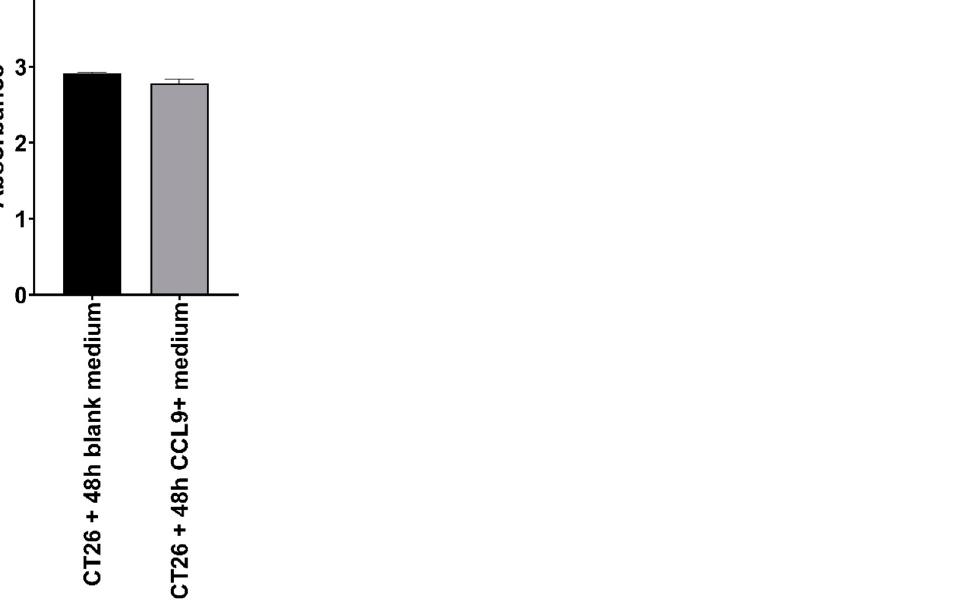
Figure 4. Migration of the unmodified CT26 cells upon the influence of the media collected from 48-h cultures of blank control or CCL9-overexpressing CT26 cells.